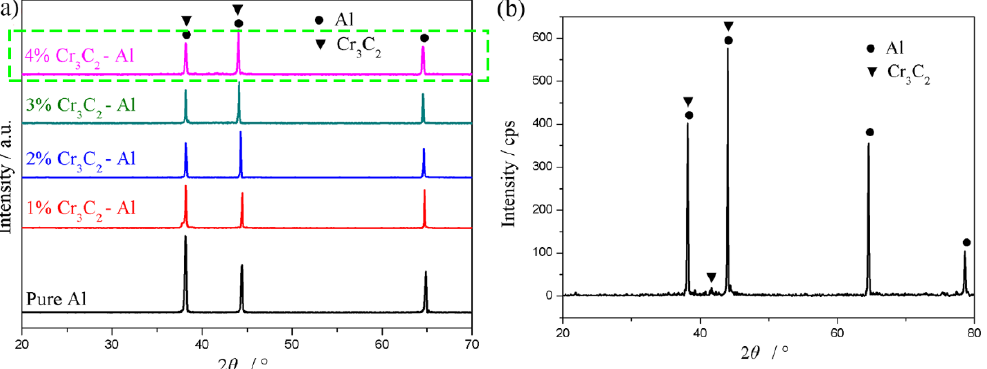
Figure 2. The XRD results of Cr 3 C 2 particle-reinforced Al matrix composite: ( a ) XRD results and ( b ) the enlarged drawing for the 4.0 wt. % Cr 3 C 2p /Al sample.